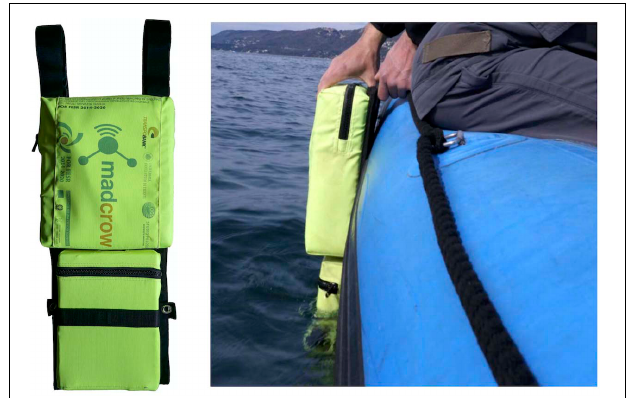
FIGURE 7 | The MaDCrow acquisition device and case: the lower segment contains sensors and is immersed; the upper segment contains all the